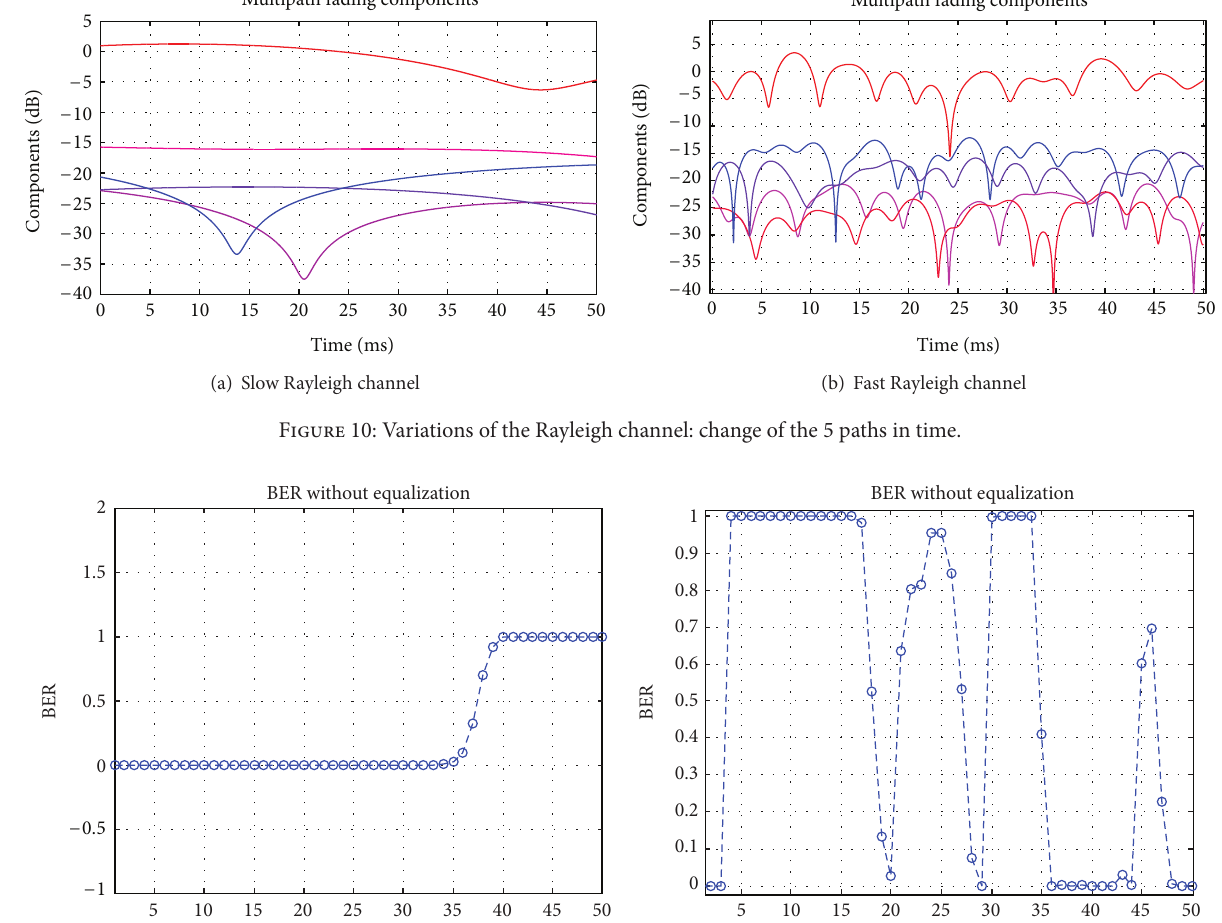
F 11: Variation of the BER at the receiver for the Rayleigh channel.